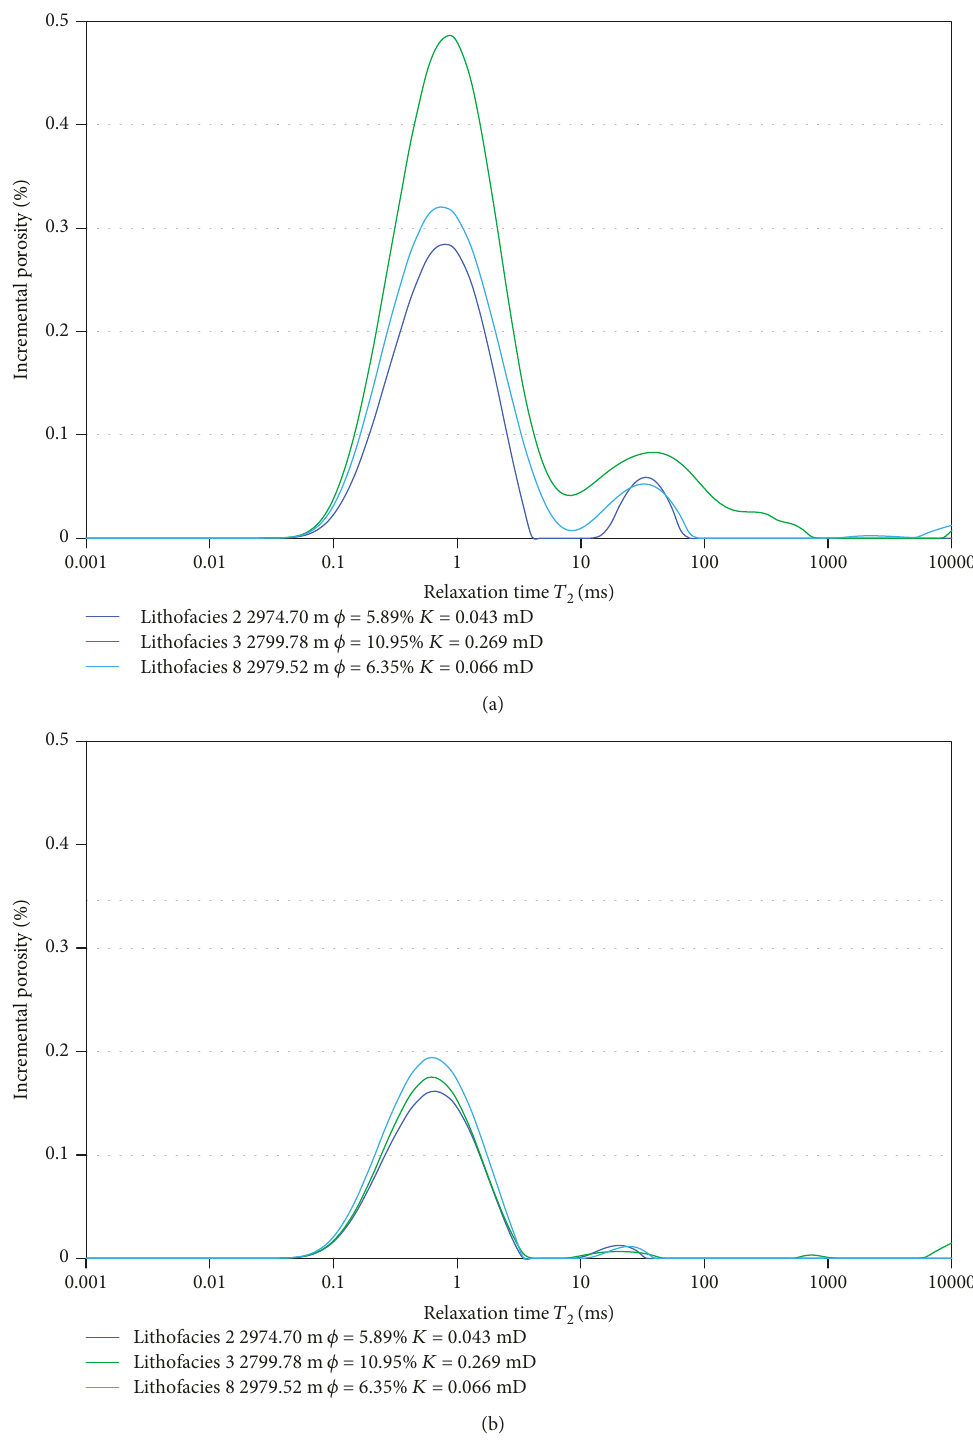
Figure 10: NMR T